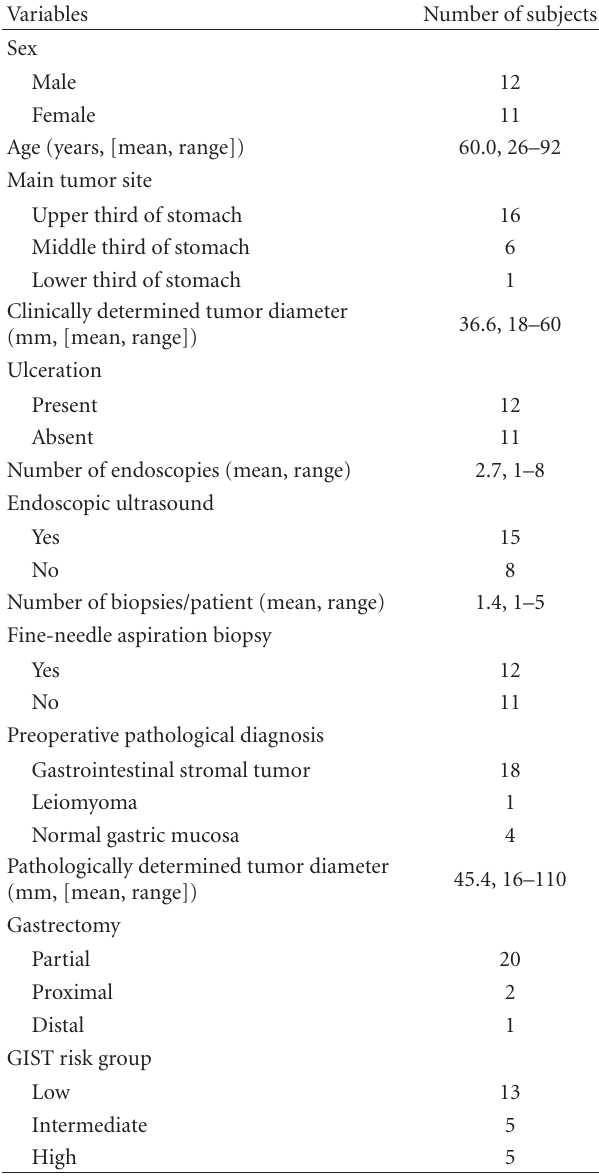
Table 1: Patients’ clinicopathological characteristics ( n =